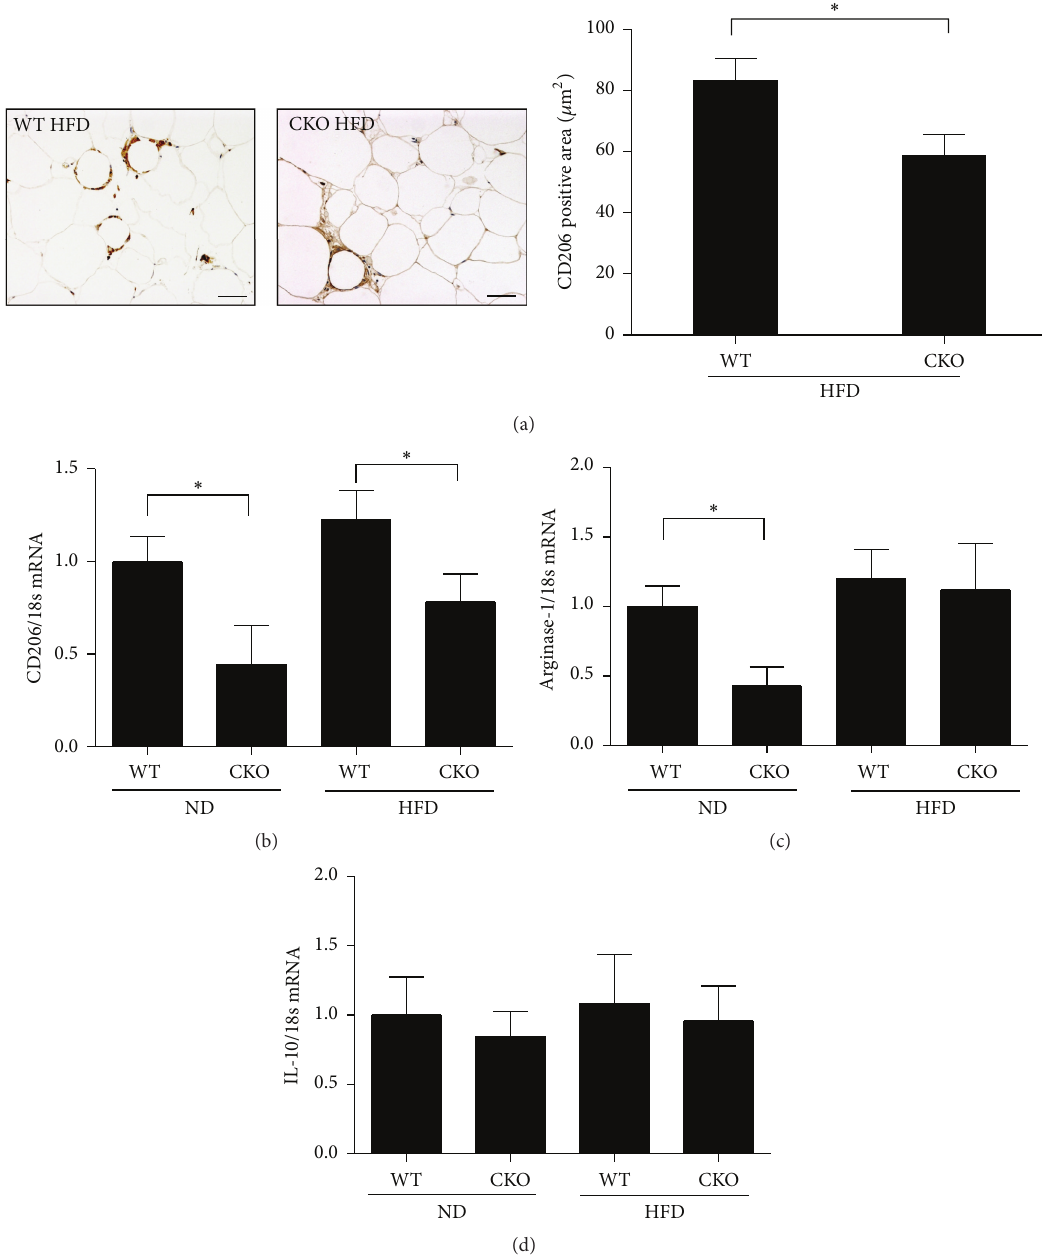
Figure 3: Catalase deficiency suppresses M2 macrophages in the stromal vascular fraction of epididymal WAT. (a) CD206 (1:20, brown) was assessed by immunohistochemistry to measure M2 activation, using hematoxylin as counterstain (blue). Images were analyzed in Image Pro. Scale bar, 50 𝜇 m; magnification, 200x. (b) CD206, (c) arginase-1, and (d) IL-10 mRNA levels were determined by real-time PCR. Data are mean ± SE of 6–8 mice. ∗ 𝑝 < 0.05